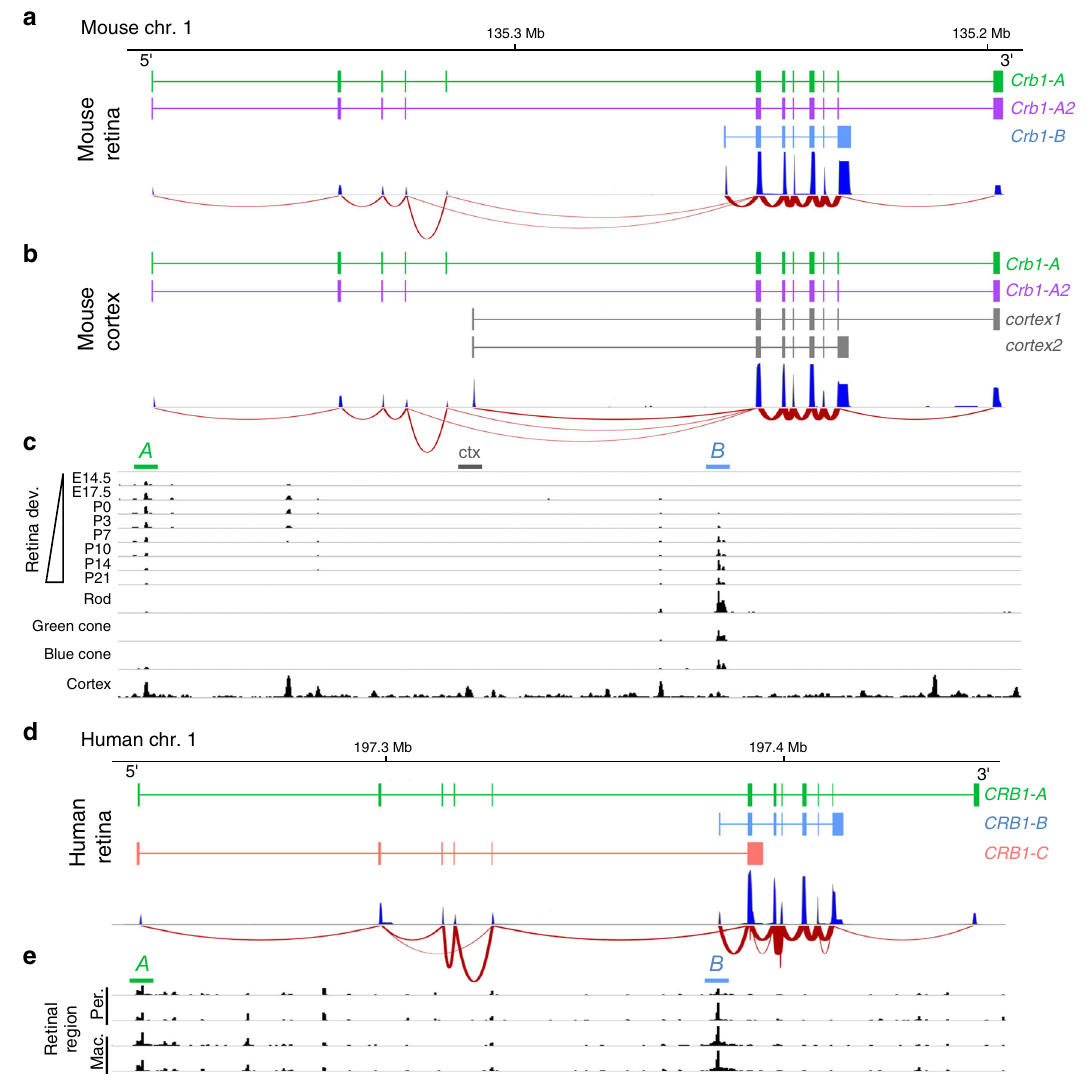
Fig. 5 Identi fi cation of a retina-speci fi c Crb1 isoform in mouse and human retina. Transcript maps of most abundant Crb1 isoforms from mouse retina ( a ) and cortex ( b ). Map depicts reverse strand of mouse chromosome 1 at indicated location (Mb, megabase). 5 ′ and 3 ′ ends of Crb1 transcripts are indicated. A is the canonical isoform; A2 is a minor splice variant of A . These isoforms are shared between retina and cortex, whereas Cortex 1, Cortex 2 , and Crb1-B are tissue-speci fi c. Corresponding exon coverage (dark blue) and sashimi plots (red lines) were generated from lrCaptureSeq dataset. Note prevalence of reads associated with Crb1-B isoform ( a ). c Assay for chromatin accessibility (ATAC-seq; GSE102092, GSE83312) identi fi es likely promoters of Crb1-A and - B isoforms. Colored bars indicate location of putative A (green) and B (blue) promoters. Maps in a – c are aligned with each other. Crb1-A promoter is more open during development, but stays accessible in mature retina. Crb1-B promoter is open and presumed active in mature rods and both types of cones. Dnase I hypersensitivity data from ENCODE project reveals distinct chromatin environment in frontal cortex, consistent with expression of A isoform, as well as shorter cortex isoforms ( cortex 1 and 2 ; gray bar at top). d Transcript maps of most abundant human retinal CRB1 isoforms, identi fi ed by lrCaptureSeq. Map depicts forward strand of human chromosome 1 at indicated location. A and B isoforms are highly homologous to mouse ( a ). CRB1-C encodes a putative secreted form of the protein; it was also identi fi ed in the mouse dataset but its relative abundance in mouse was much lower than A and B . Note that Crb1-A2 was not detected in the human dataset. Exon coverage (dark blue) and sashimi plots (red lines) were generated from lrCaptureSeq data. e ATAC-seq (GSE99287) of human peripheral (per.) and macular (mac.) retina show open regulatory sites corresponding to putative promoters for CRB1-A (green bar) and CRB1-B (blue bar). Two biological replicates are shown. Maps in d , e are aligned with each